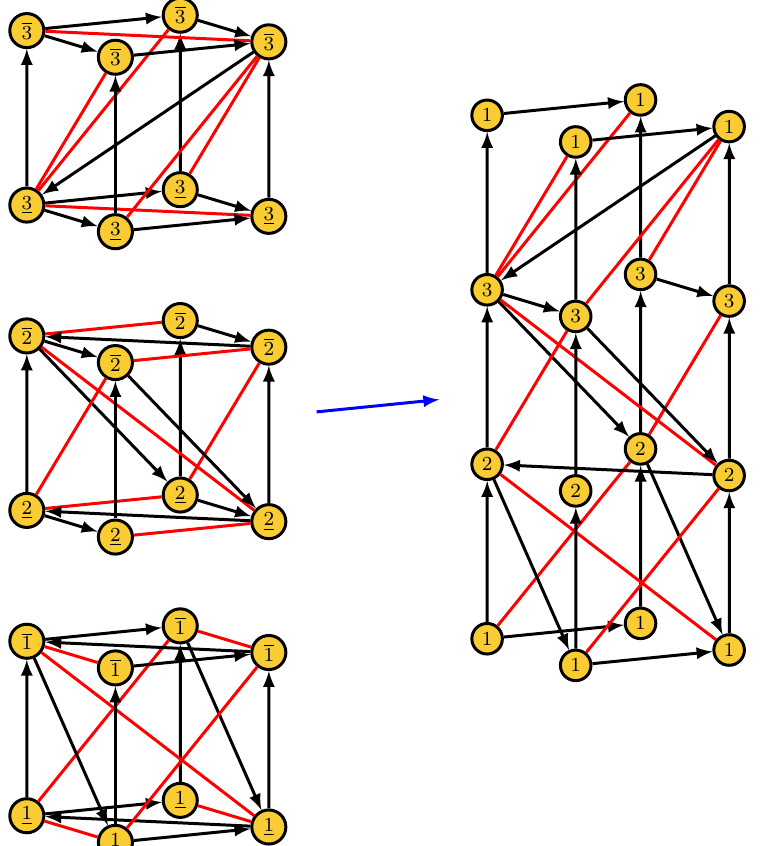
Figure 11. 3 d printing of the periodic quiver for D 3 using three C 3 quiver blocks corresponding to di(cid:11)erent perfect matchings. Massive chiral-Fermi pairs are integrated out.